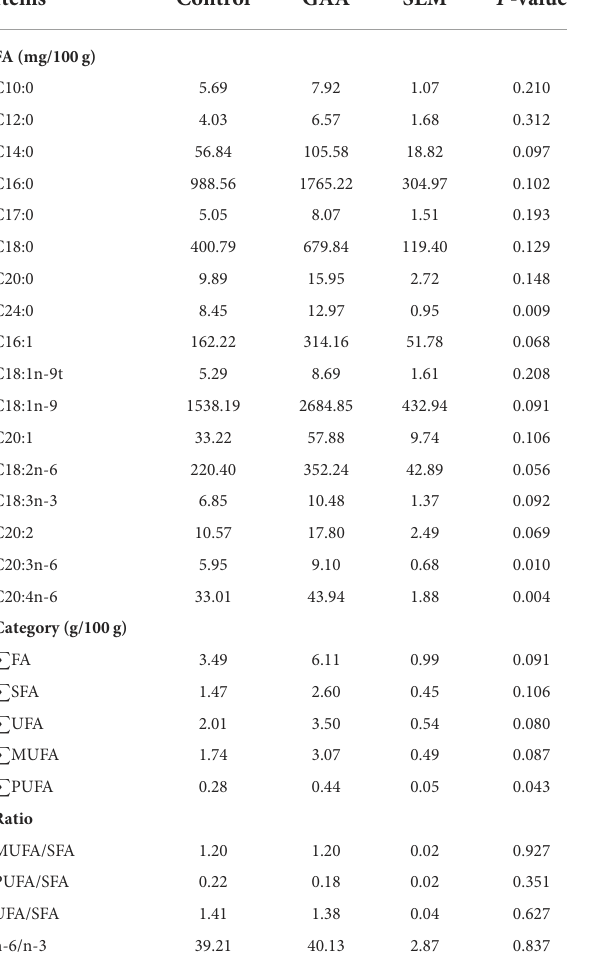
TABLE 5 Effect of dietary GAA on fatty acid contents of Longissimus thoracis in Tibetan pigs (based on wet weight). Items Control GAA SEM P -value